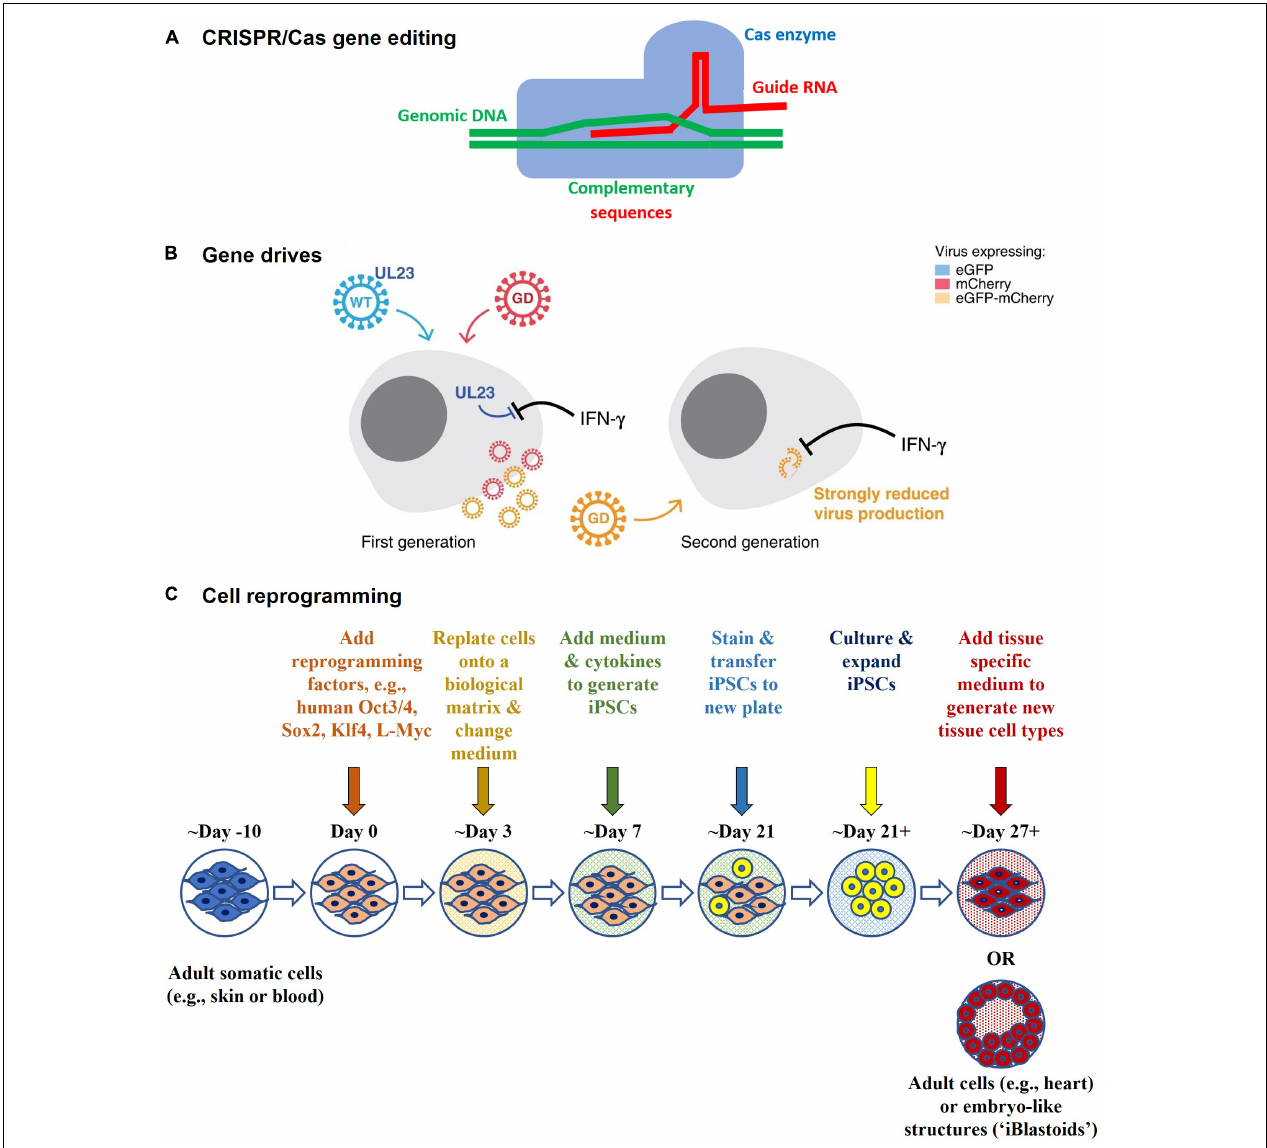
FIGURE 6 | Technological advances (A) CRISPR/Cas gene editing – CRISPR/Cas comprises an enzyme (Cas), which is complexed with a synthetic guide RNA that directs the enzyme to a target site in the genome where it cleaves specific DNA sequences and allows sequences to be added, removed, or altered in situ (i.e., “edited”). Cas9 is the first gene editing enzyme developed by Emmanuelle Charpentier and Jennifer A. Doudna in 2012, for which they received the Nobel Prize in Chemistry in 2020. Other types of editors have been developed to provide greater safety, functionality, and finer control over gene editing. (B) Gene drives – Gene drives are genetic elements that are favored for inheritance. They increase the rate at which certain genes are inherited by the offspring of reproducing organisms, thus spreading the genes faster through a species than would normally occur. They can be used to preferentially propagate chosen genetic modifications in a target population, even if deleterious to the population. They can be generated in organisms that reproduce sexually (e.g., mosquitos for malaria control) or asexually (e.g., bacteria [ E. coli ] and viruses [Human cytomegalovirus (HCMV)]), and may have potential for infectious disease control. The schematic is from Walter and Verdin (61) and shows how a gene drive (“GD”) in HCMV might be used to target and replace wildtype HCMV (“WT”) in cell culture experiments. The WT expresses UL23 which blocks interferon-gamma (IFN- γ ) antiviral responses, whereas in the GD UL23 is knocked out, thus making the GD susceptible to IFN- γ . In addition, they each express a different marker protein that enables them to be distinguished from each other via fluorescence microscopy. The WT expresses a green fluorescent marker protein (eGFP), whereas the GD expresses a red fluorescent marker protein (mCherry). Recombination between the WT and GD gives rise to recombinant GD + viruses that are strongly inhibited by IFN- γ when infecting other cells and that express both marker proteins (eGFP-mCherry). (C) Cell reprogramming - Mature (adult somatic) cells can be reprogrammed in the laboratory to an immature state (as induced pluripotent stem cells, iPSCs) by treating them with reprogramming factors. They can then be differentiated into other types of mature cells. For example, an adult skin cell can be reprogrammed to become a heart muscle cell. It may not be necessary to go through the stem cell state, as direct reprogramming from one type of mature cell (e.g., skin) to another (e.g., heart) is possible in the laboratory. Reprogramming factors may be introduced into cells using gene technology (such as via viral vector or plasmid transduction) or without gene technology (such as via chemical protein induction). The Polo laboratory at Monash University generated human embryo-like structures (“iBlastoids”) from adult skin cells using such processes